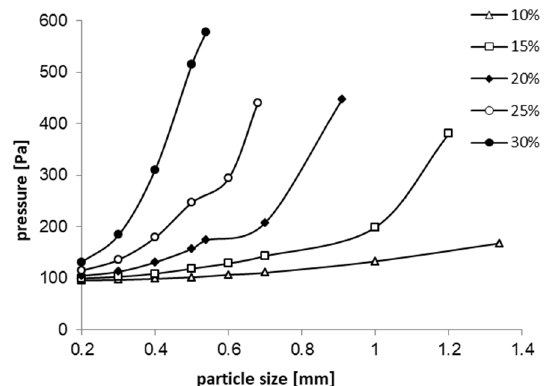
Figure 15. Pressure drop depending on the solid particles size for different solid volume fractions at 140 kPa.